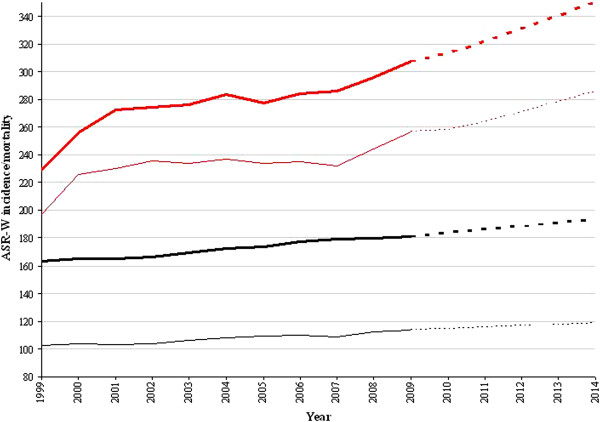
Overall cancer incidence and mortality in Serbia - trends (1999–2009) and predictions (2010–2014). Legend: Red bold line – incidence, men. Red regular line – incidence, women. Black bold line – mortality, men. Black regular line, mortality, women. All dotted lines continuous to these are depicting predictions.